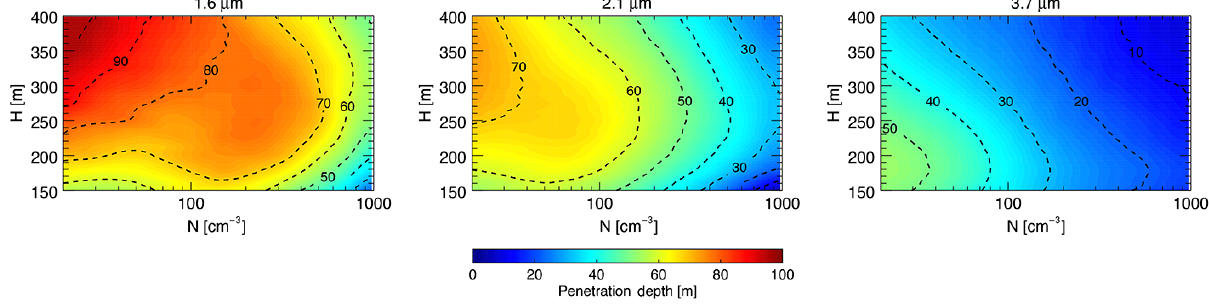
Figure 2. Average penetration depth relevant for effective radius retrievals of CDNC in the ISBLC. For the purpose of this study, we define the penetration depths as the vertical distance below cloud top at which the retrieved effective radius equals the effective radius predicted by the